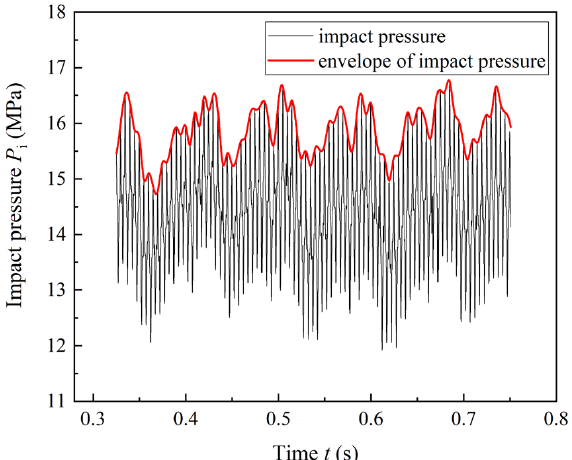
Figure 4. Typical axial impact pressure fluctuation in time domain. Experimental conditions: P in =